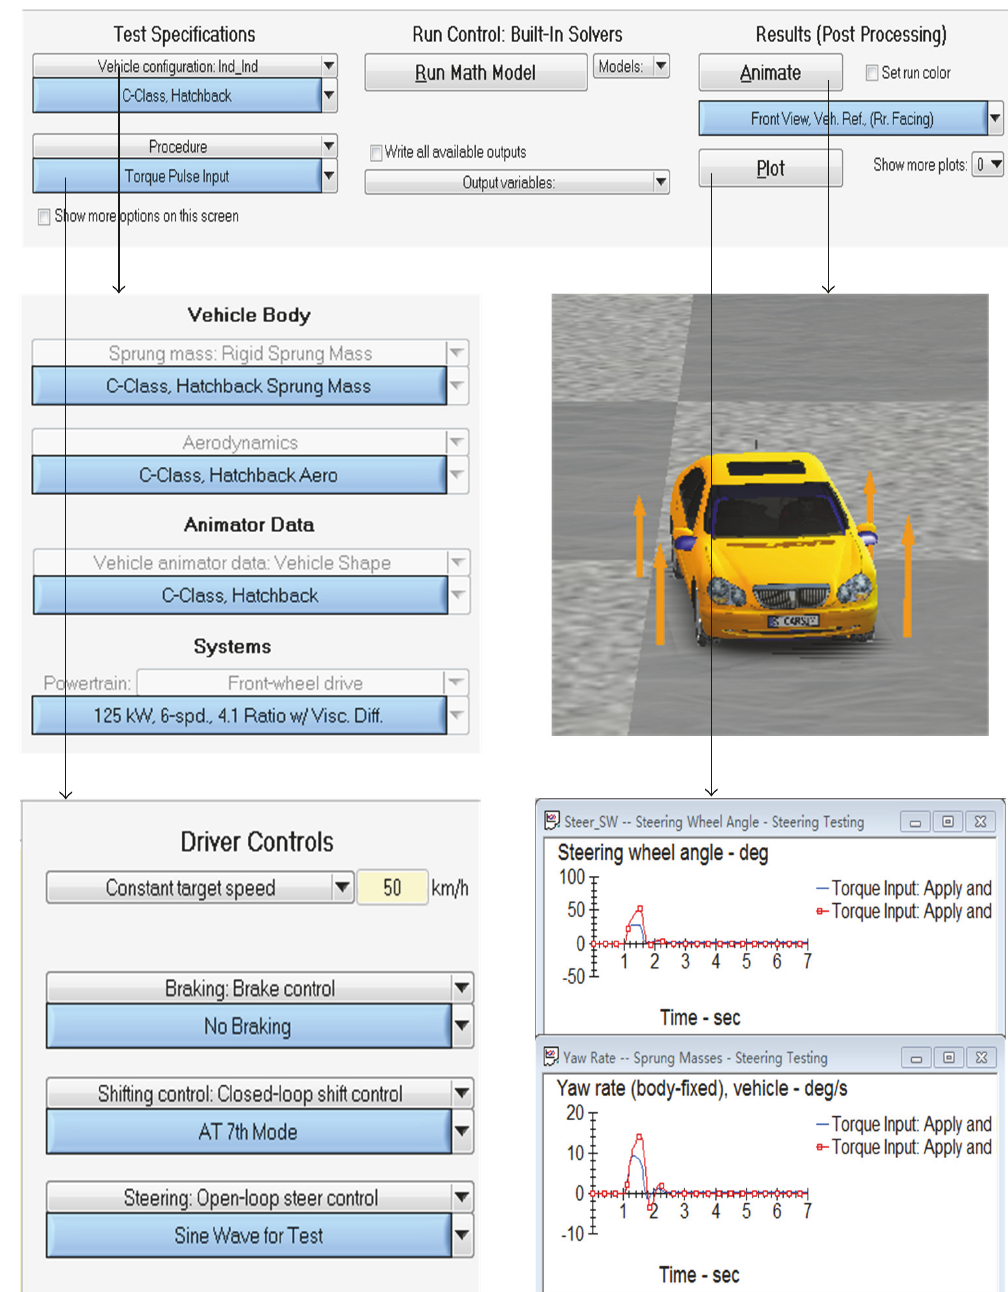
Figure 3: The main interface and constitution of